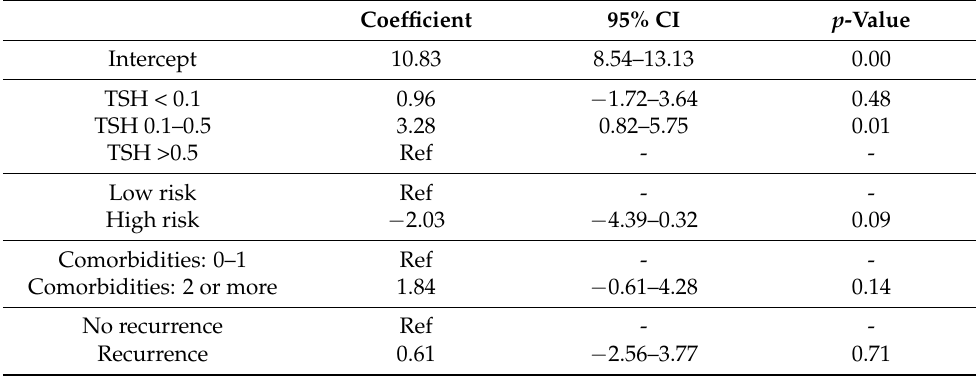
Table 3. Levels of TSH and other clinical variables, and the severity of anxiety in patients with DTC. Multivariate